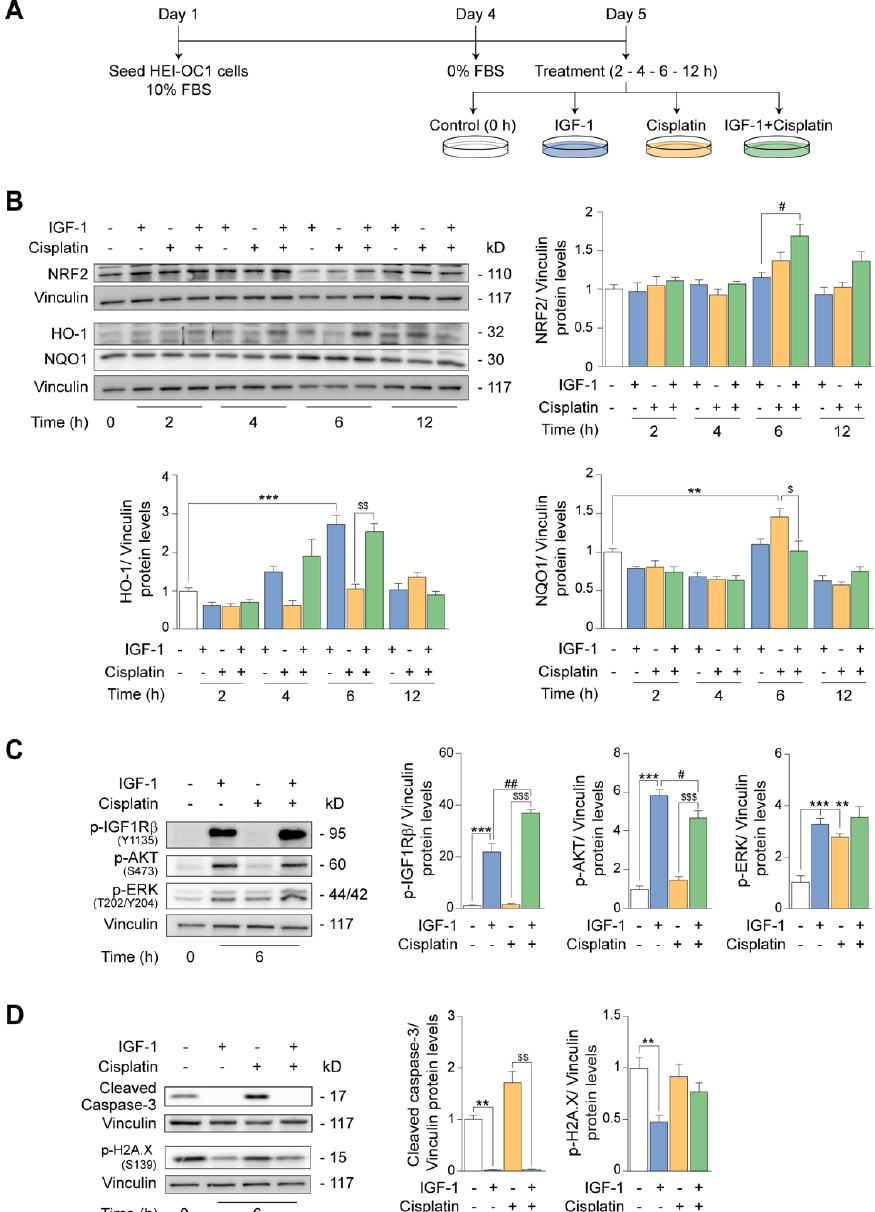
Figure 6 . Ototoxic effects induced by short − term exposure to cisplatin are neutralized by IGF − 1. ( A ) HEI − OC1 P cells were cultured in DMEM with 10% FBS for 72 h and then switched to a control medium for 24 h and left untreated (white bars) or treated with IGF − 1 (10 nM) (light blue bars), cisplatin (4 µg/mL) (yellow bars) or a combination of both (green bars) for 2, 4, 6 and 12 h and lysed for the analysis of target proteins. ( B ) Levels of NRF2, HO − 1 and NQO1 were measured by Western blotting. Representative immunoblots from at least n = 4 independent experiments are shown. ( C ) Levels of p − IGF1R β (Tyr1135), p − AKT (Ser473) and p − ERK (Thr202/Tyr204) were analyzed by Western blotting. Representative immunoblots from at least n = 4 independent experiments are shown. ( D ) Levels of cleaved caspase − 3 and p − H2A.X (Ser139) were measured by Western blotting. Representative immunoblots from at least n = 3 independent experiments are shown. Vinculin was used as a loading control. Data are expressed as mean ± SEM. Statistical significance was determined by one − way ANOVA: ** p < 0.01 and *** p < 0.001 versus control (0 h); # p < 0.05 and ## p < 0.01 versus IGF − 1; $ p < 0.05, $$ p < 0.01 and $$$ p < 0.001 versus cisplatin.